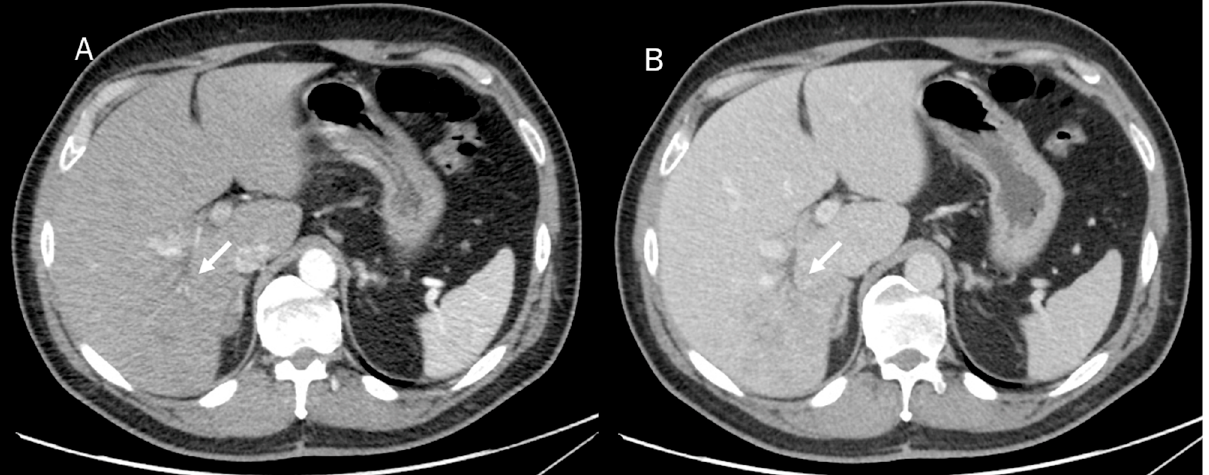
Figure 4. CT assessment of ICC (arrow) during arterial ( A ) and portal ( B ) phase of contrast study. The lesion (arrow) shows an infiltrative pattern with biliary tree dilatation.